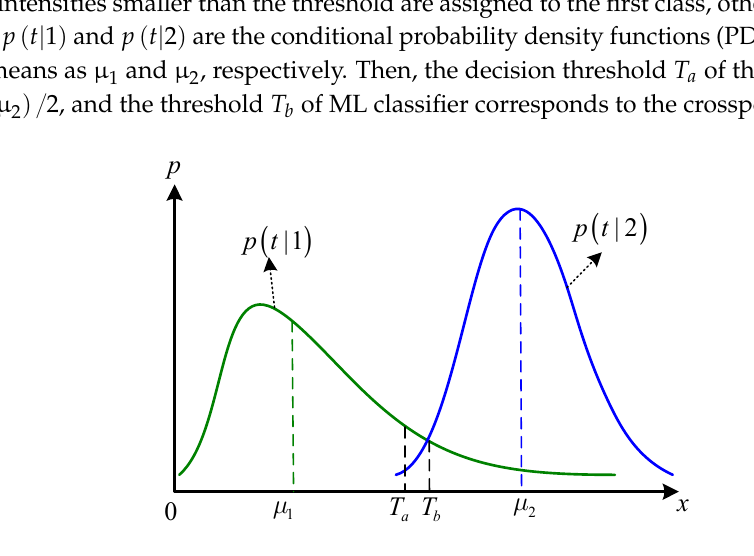
Figure 2. Illustration of decision thresholds in k-means and maximum likelihood (ML) methods.